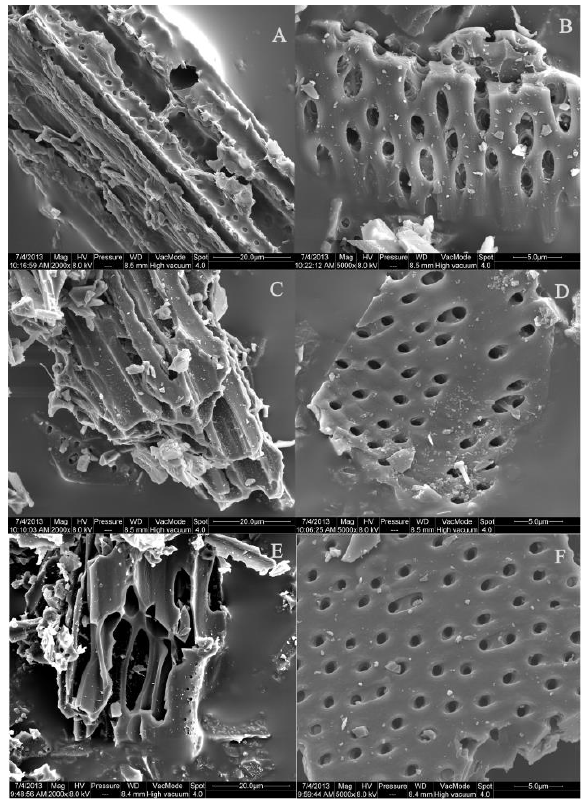
Figure 1. SEM images of biochars under different pyrolytic temperatures. B300 is shown in ( A , B ); B500 is shown in ( C , D ); and B700 is shown in ( E , F ). ( A , C , E ) are magnified 2000 × and ( B , D , F ) are magnified 5000 ×